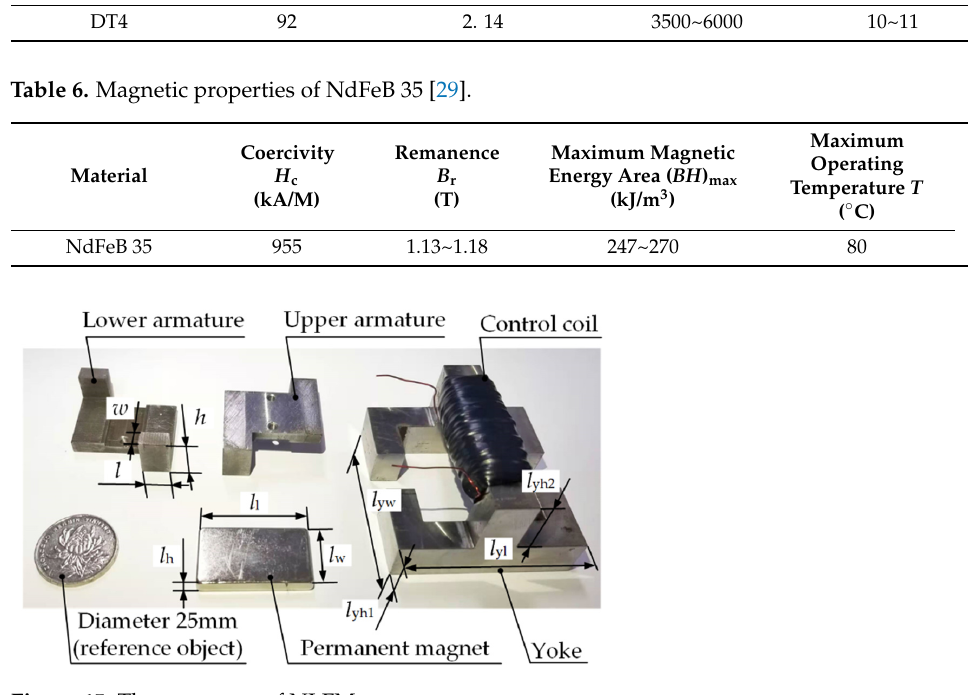
Figure 15. The prototype of NLFM.